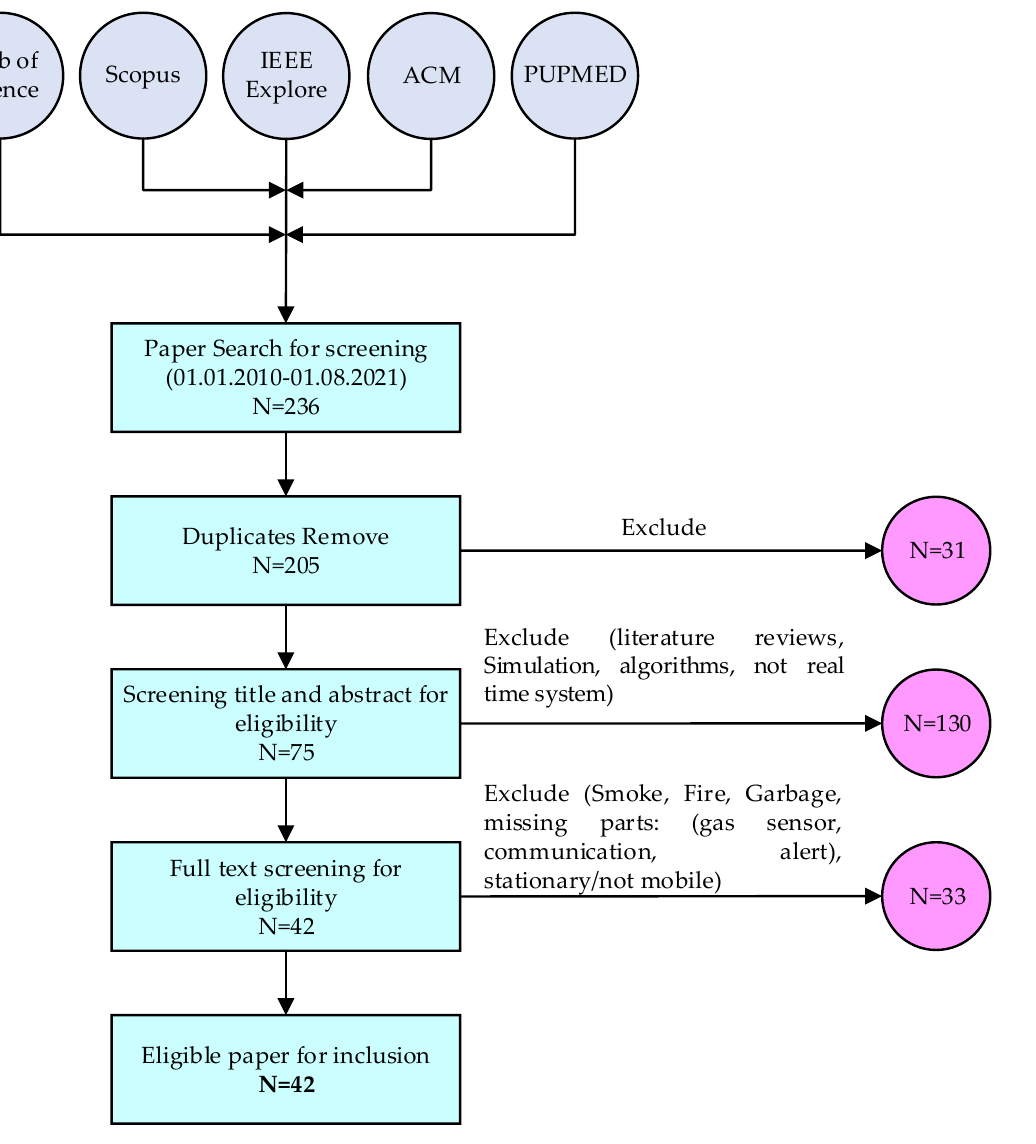
Figure 3. Flowchart of the papers selection process.